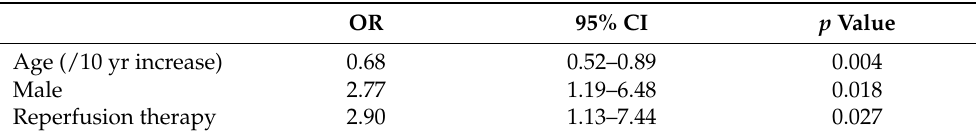
Figure 2. Functional state at discharge by mRS between the prolonged LOS group and the non- prolonged LOS group. Table 2. Multivariable analysis of predictors for prolonged LOS.